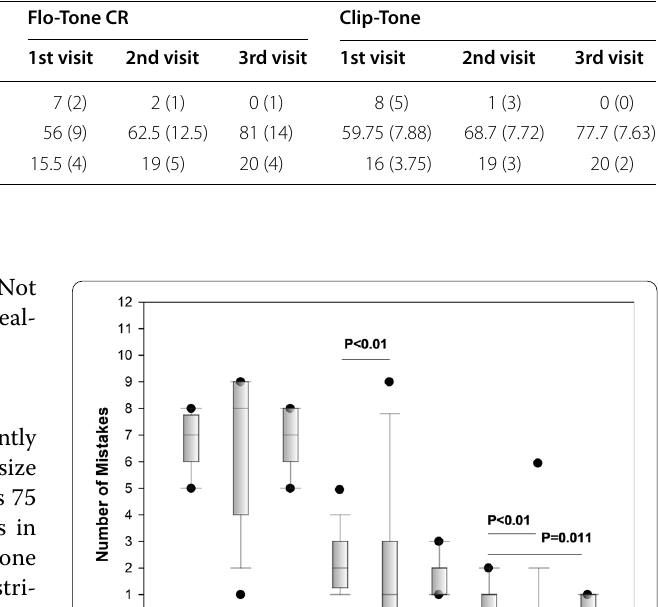
Table 2 Outcomes of patient education per intervention and visit Intervention Control